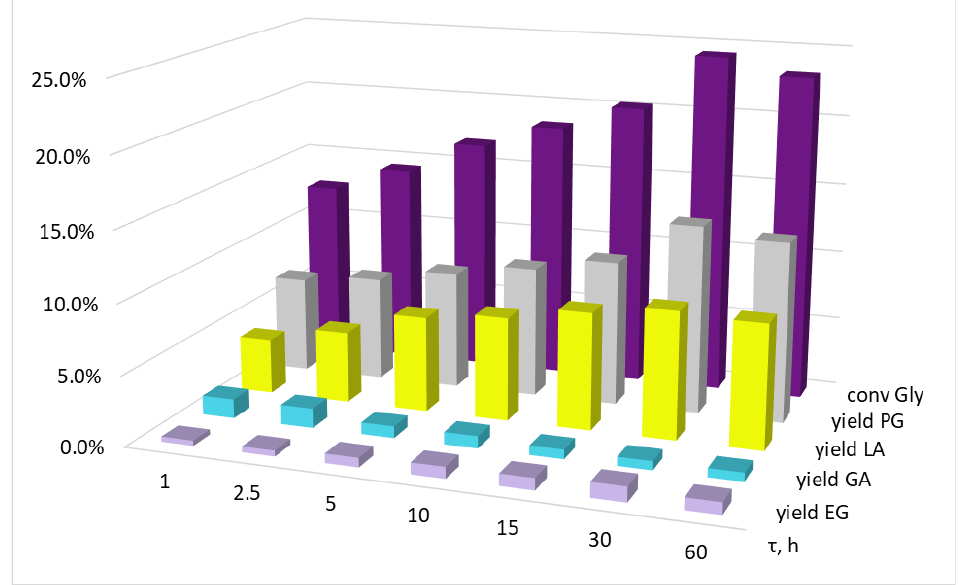
Figure 5. The influence of the reaction time on glycerol conversion and the yields of the products. Conditions: T = 220 °C, p(H2) = 3.0 MPa, KOH/Cu = 5.8 mol, Gly/Cu = 50 mol, Gly/H 2 O = 4.1 vol, precursor salt = Cu(OAc) 2 .